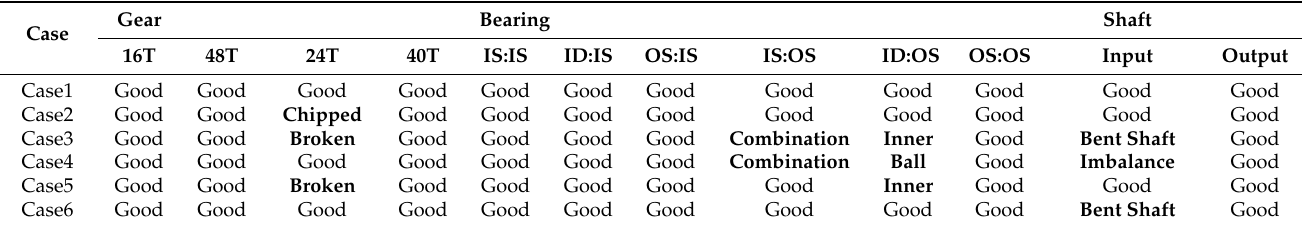
Table 8. Gearbox Health Status Description.